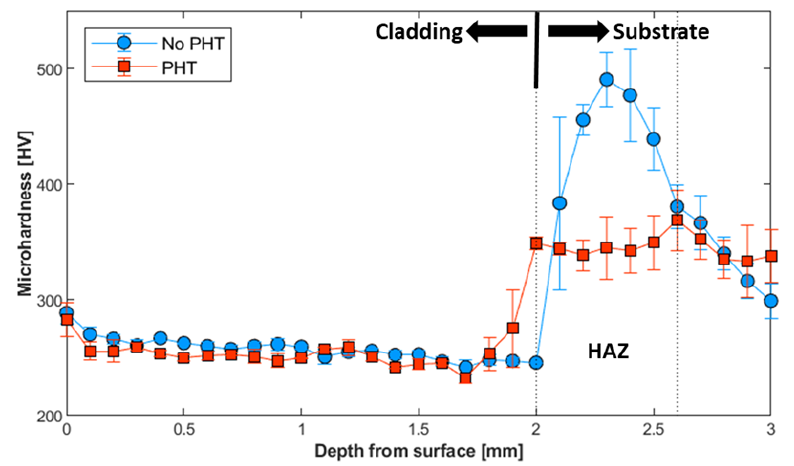
Figure 13. Microhardness profile of cladded samples applying the I2_6_20 condition with and without PHT.